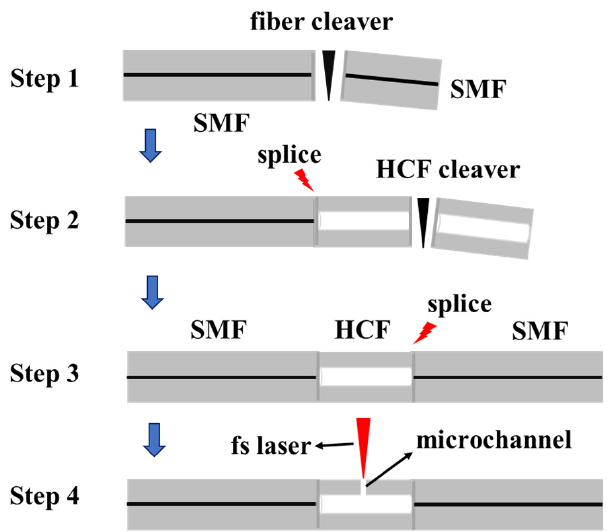
Figure 1. Schematic diagram of a fusion splicing process between SMF and HCF.